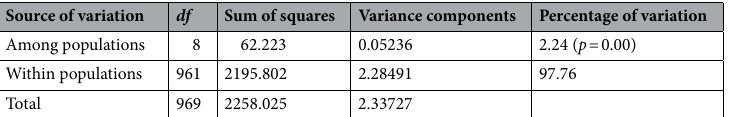
Source of variation df Sum of squares Variance components Percentage of variation Among